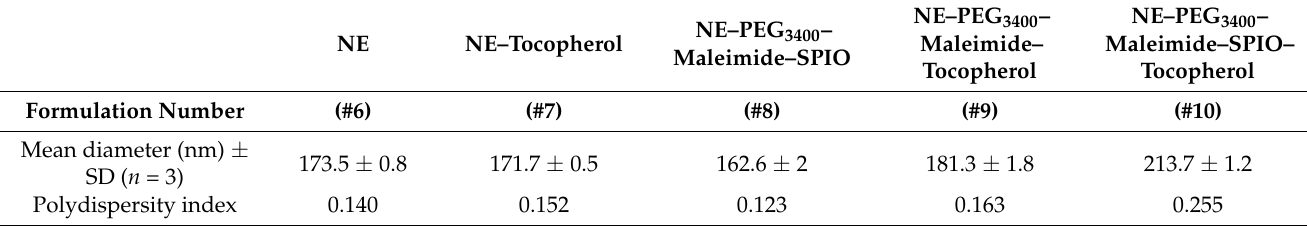
Table 4. NE characterization.